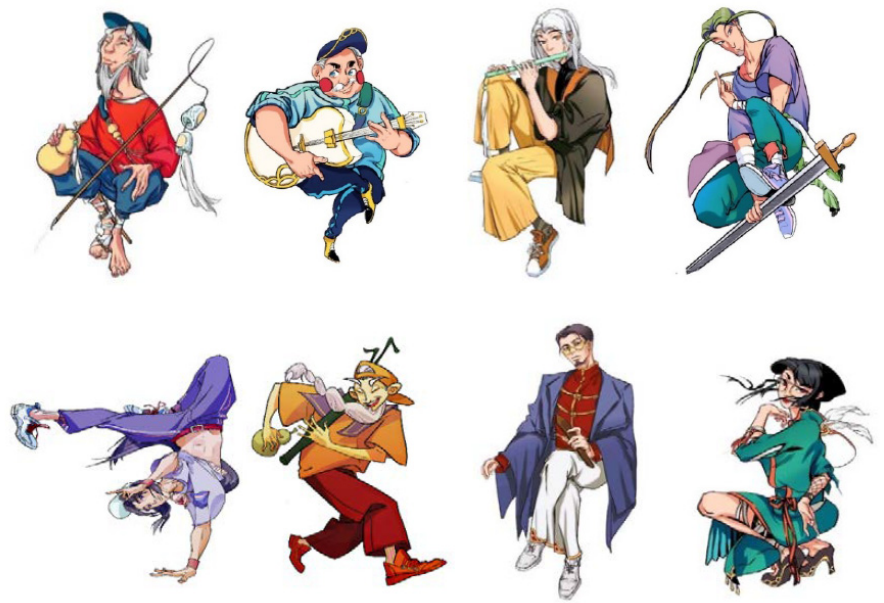
Figure 9. Eight Immortals designed based on hip-hop culture.